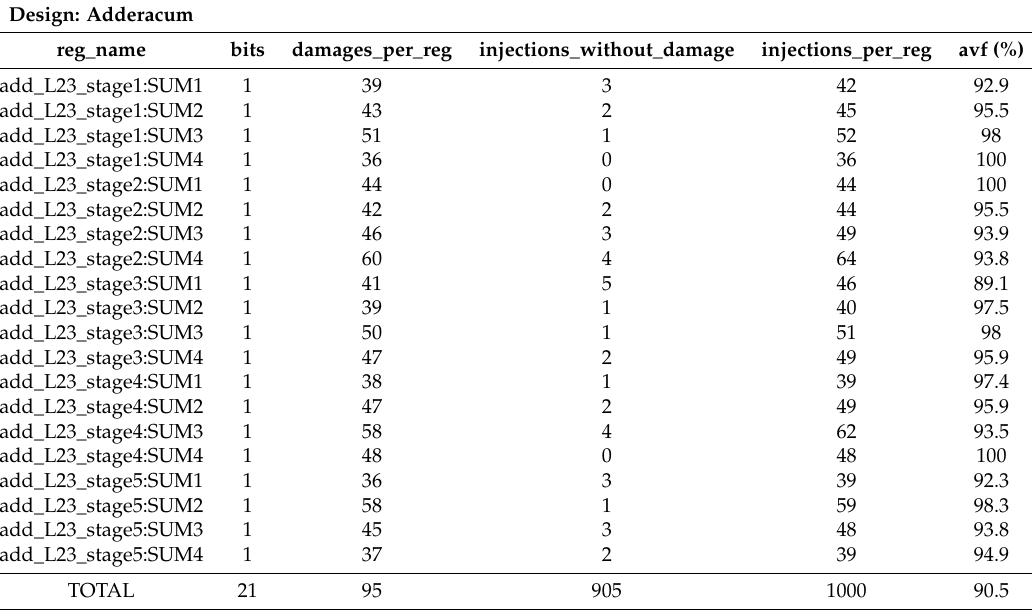
Table 2. Campaign for adder_acum design.